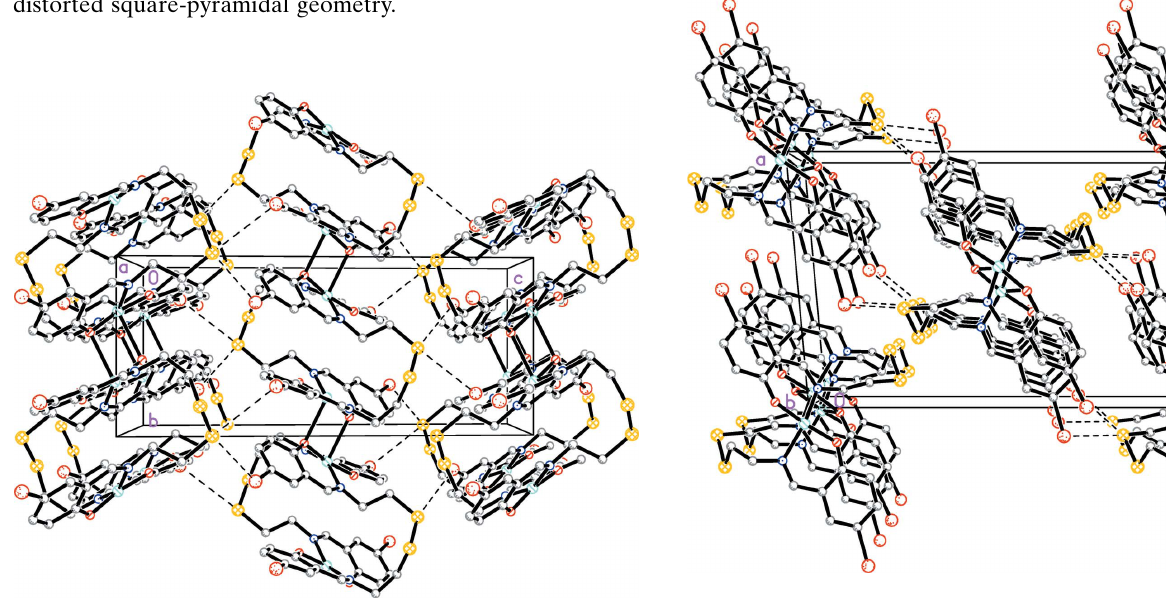
Figure 3 The crystal packing of the title compound viewed along the b axis. Short S (cid:2)(cid:2)(cid:2) Br contacts are shown as dashed lines. H atoms are not shown.